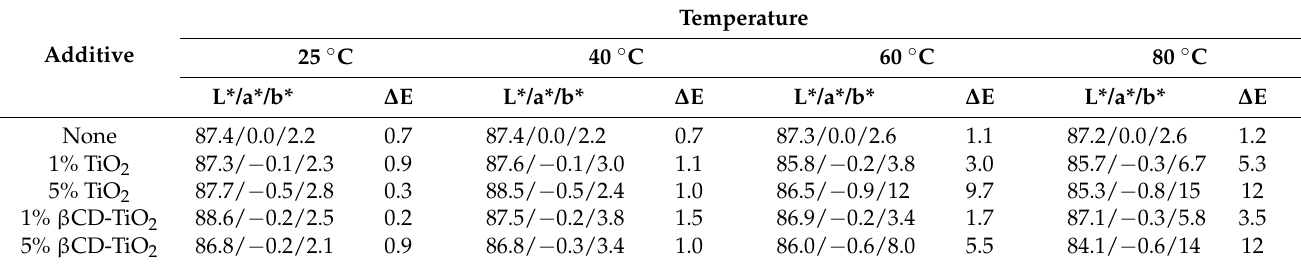
Table 1. L*, a*, b*, and ∆ E color parameters obtained for ethylene–PVA copolymers (EVOH) composite films after aging for at different temperatures and 80% relative humidity.